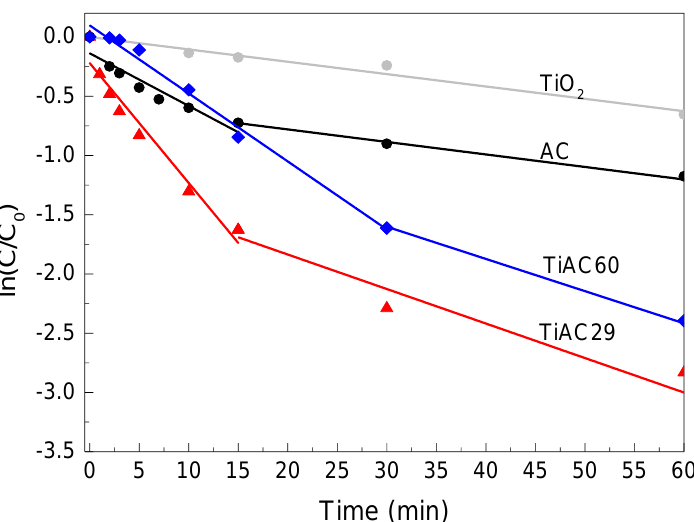
Figure 12. Apparent first-order kinetics of MB adsorption+photocatalytic removal for TiO 2 , AC, and TiACX catalysts under simulated visible light irradiation.